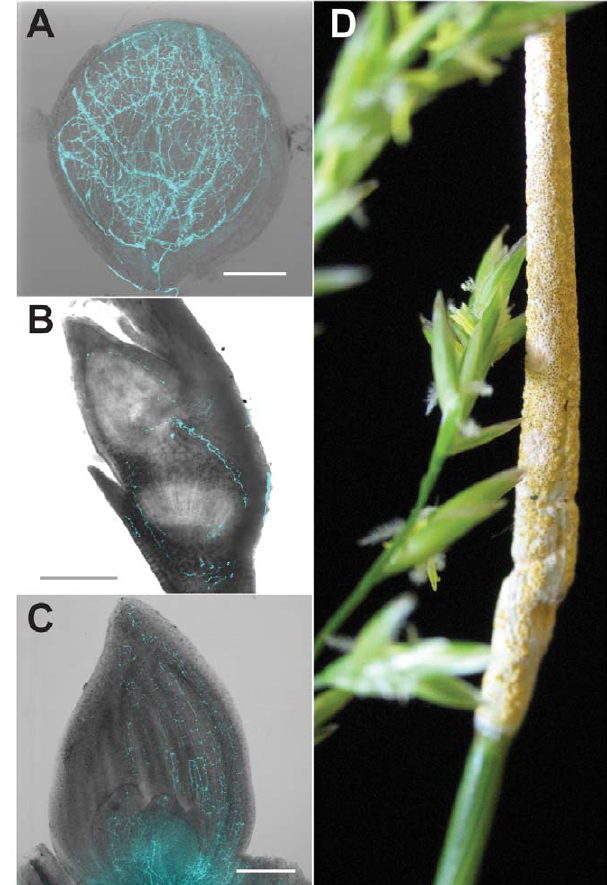
Figure 1. Symbiosis of meadow fescue with Epichloe¨festucae , a heritable symbiont. Single optical slice confocal micrographs of E. festucae expressing enhanced cyan-fluorescent protein were overlain with DIC bright field images of (A) ovules (bar=100 m m), (B) embryos (bar=200 m m), and (C) shoot apical meristem and surrounding new leaves (bar=200 m m). (D) Asymptomatic (left) and ‘‘choked’’ (right) inflorescences simultaneously produced on a single grass plant infected with a single E. festucae genotype. Vertical (seed) transmission of the symbiont occurs via the asymptomatic inflorescence, whereas the choked inflorescence bears the E. festucae fruiting structure (stroma), which produces sexually derived spores (ascospores) that mediate horizontal